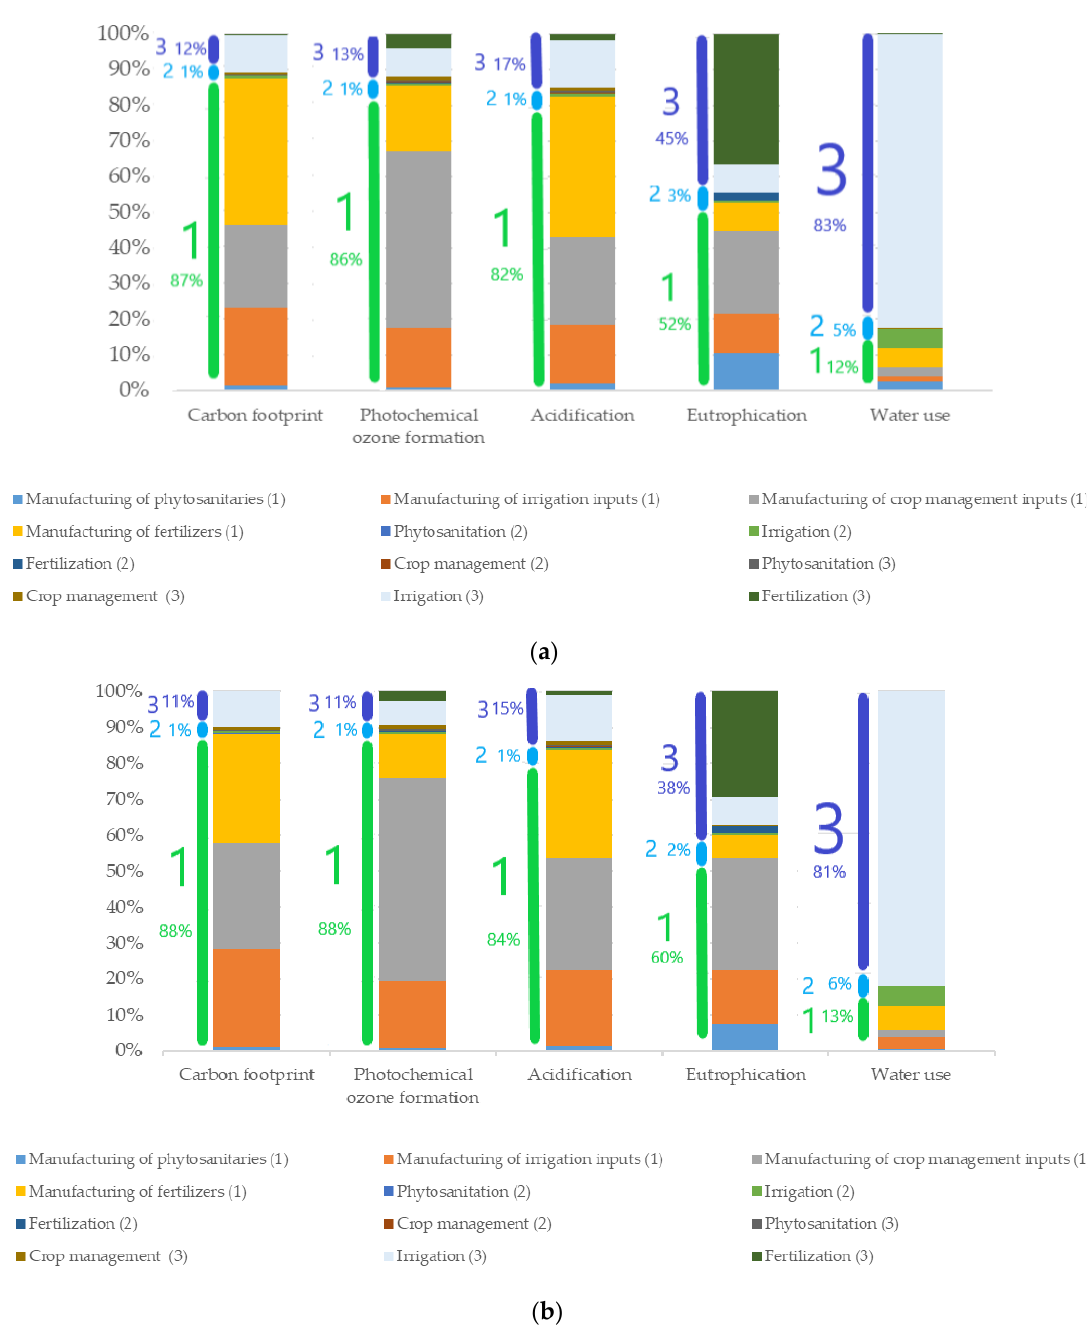
Figure 2. Percentage contribution by substage and process on each impact category considering conventional UA ( a ) and precision agriculture VA practices ( b ). (1) Manufacturing of inputs, (2) crop establishment, (3) crop production.